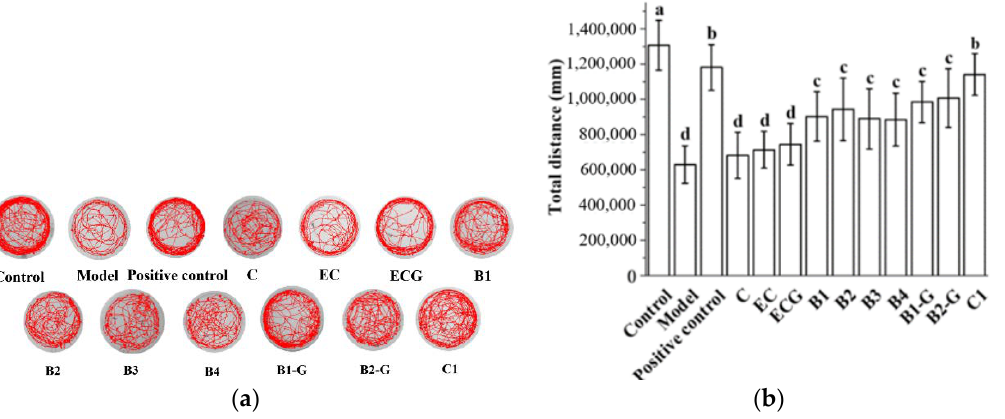
Figure 7. Effects of different structural procyanidins on exercise capacity in the zebrafish PD model.